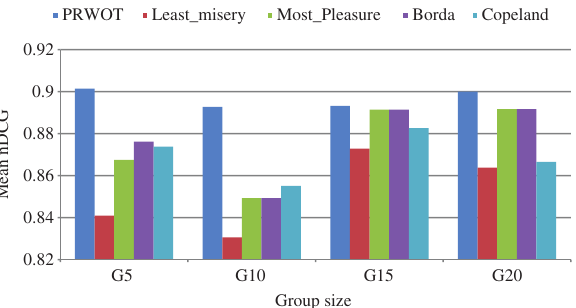
Figure 11: The Effectiveness of Group Recommendation with Rank Aggregation